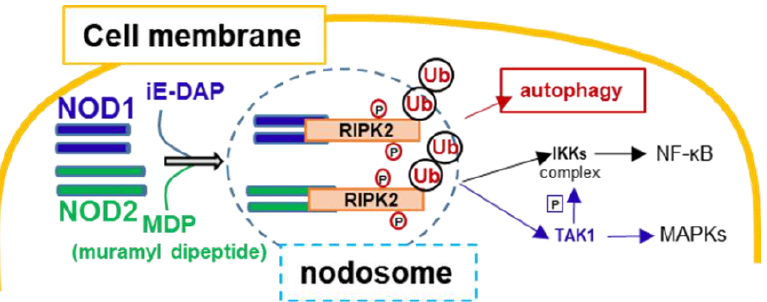
Figure 2. NOD1/NOD2 ( nodosome ) activation and signaling. NOD1 or NOD2 dimerize after MAMPs/PAMPs binding, recruiting the kinase RIPK2 that becomes autophosphorylated and polyubiquitinated. This nodosome promotes additional intracellular signaling via TAK1/IKK activation that results in the activation of Mitogen-Activated Protein Kinases (MAPKs) and NF-κB translocation to the nucleus.